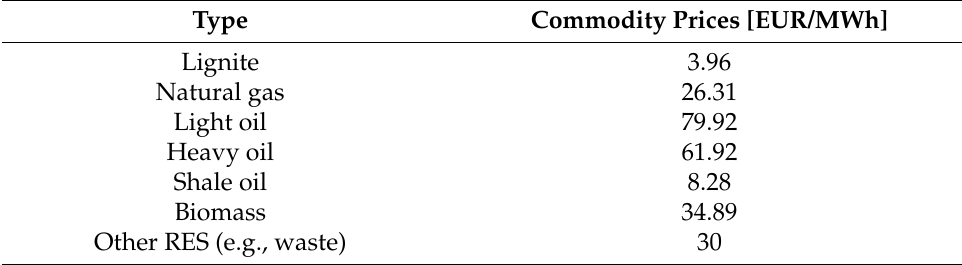
Table 1. Cost overview of prime energy sources. Data from